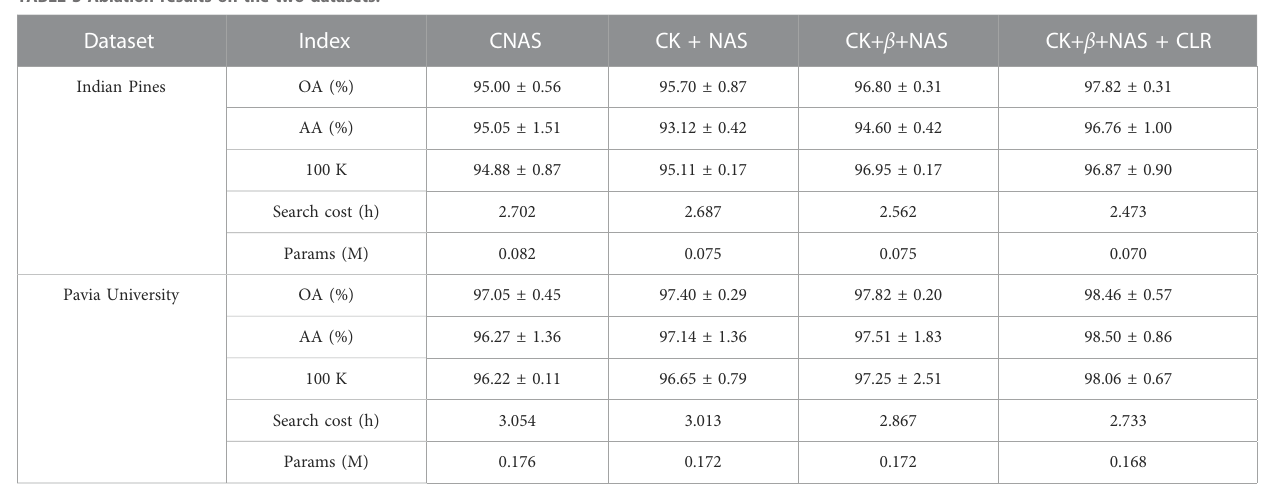
TABLE 3 Ablation results on the two